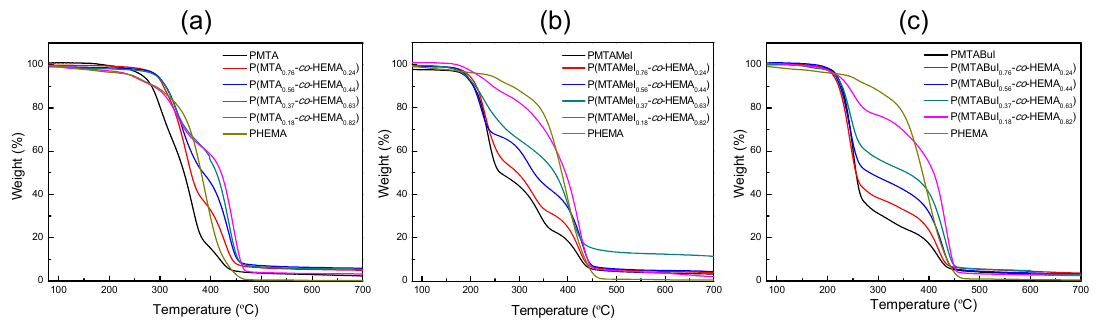
Figure 5. Thermogravimetric analysis of the ( a ) P(MTA- co -HEMA), ( b ) P(MTAMeI- co -HEMA), and ( c ) P(MTABuI- co -HEMA) copolymers.